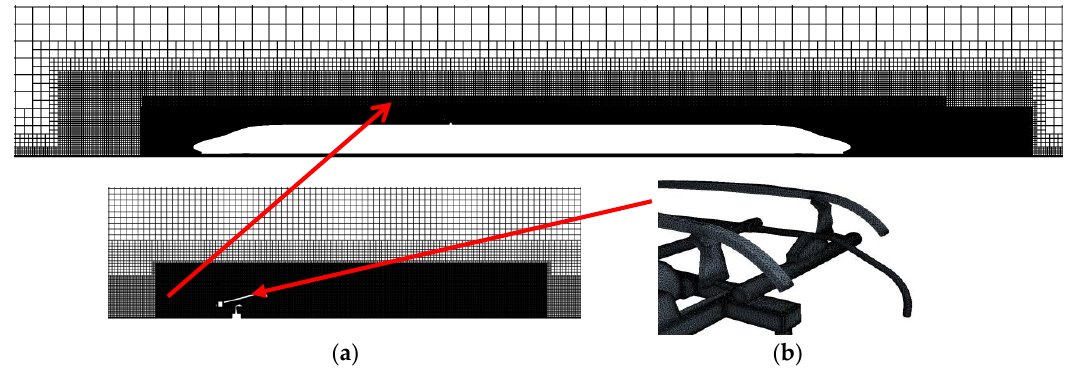
Figure 7. Medium sized computational mesh: ( a ) grid around pantograph; and ( b ) enlarged view of pantograph grid.